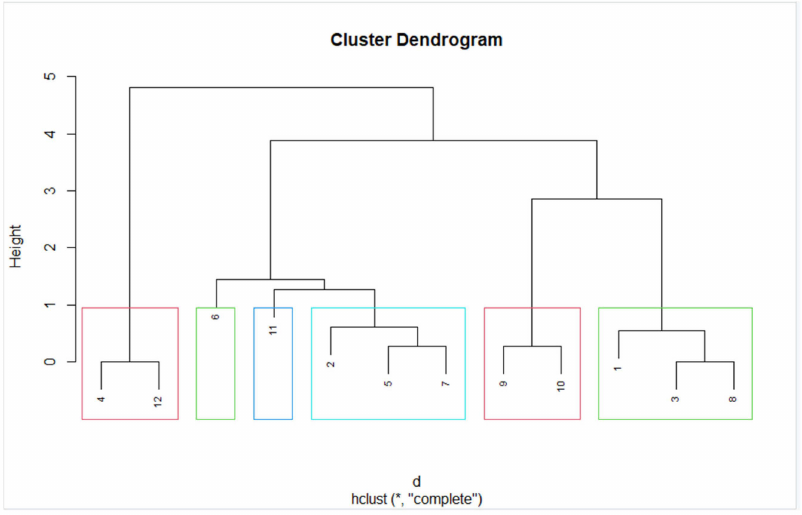
Figure 7. Dendrogram (method “ward.D2”).